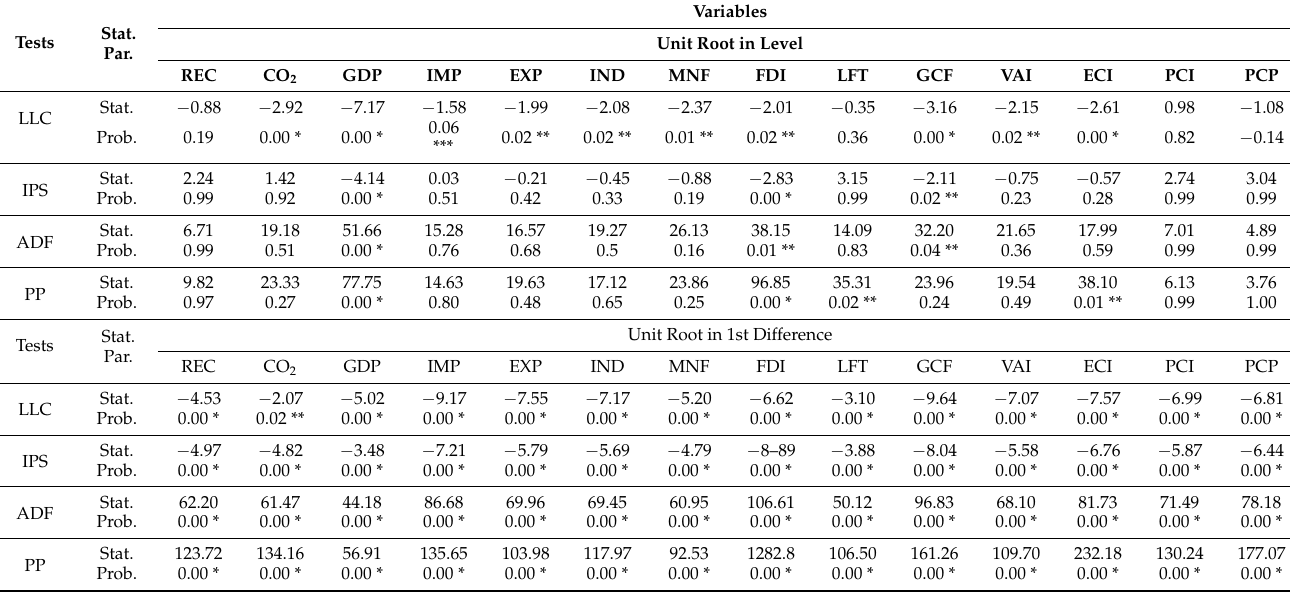
Table 3. Panel unit root results for the employed